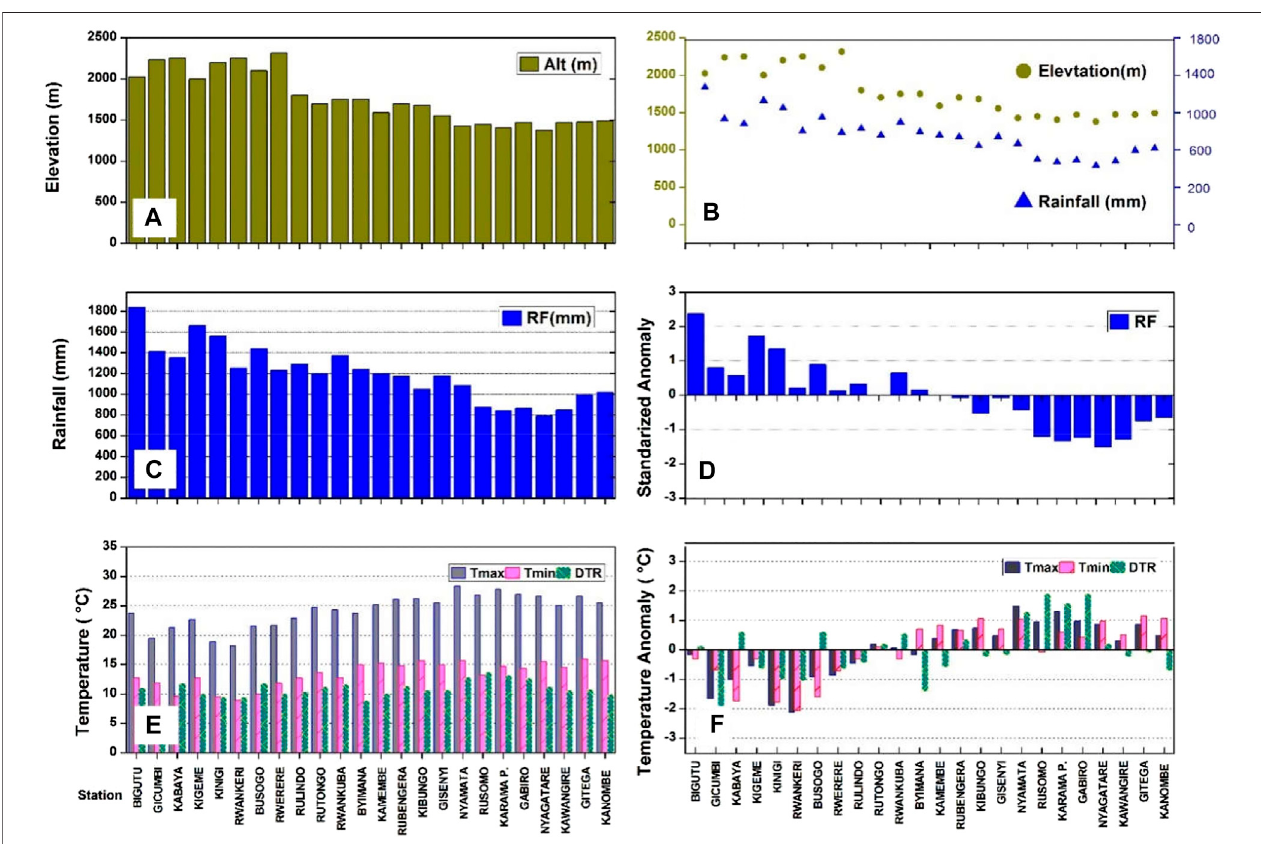
FIGURE 6 | (A) Topography distribution, (B) relationship between temperature and topography, (C) Maximum, Minimum and DTR trend, (D) maximum, minimum and DTR anomalies at every station selected for the period of 1961 – 2014.